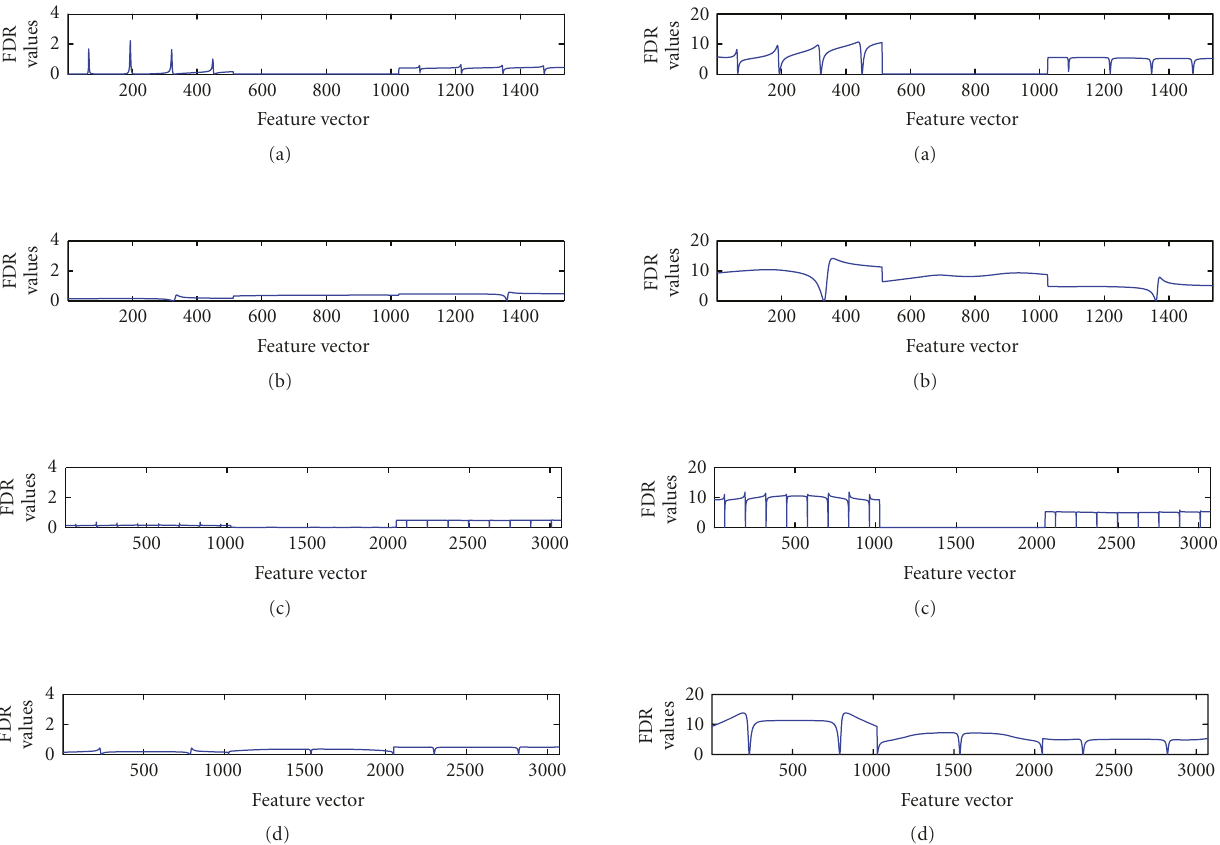
Figure 8: FDR values related to (a) (cid:9) c f , (b) (cid:9) c f feature vectors when the disturbance is sag.